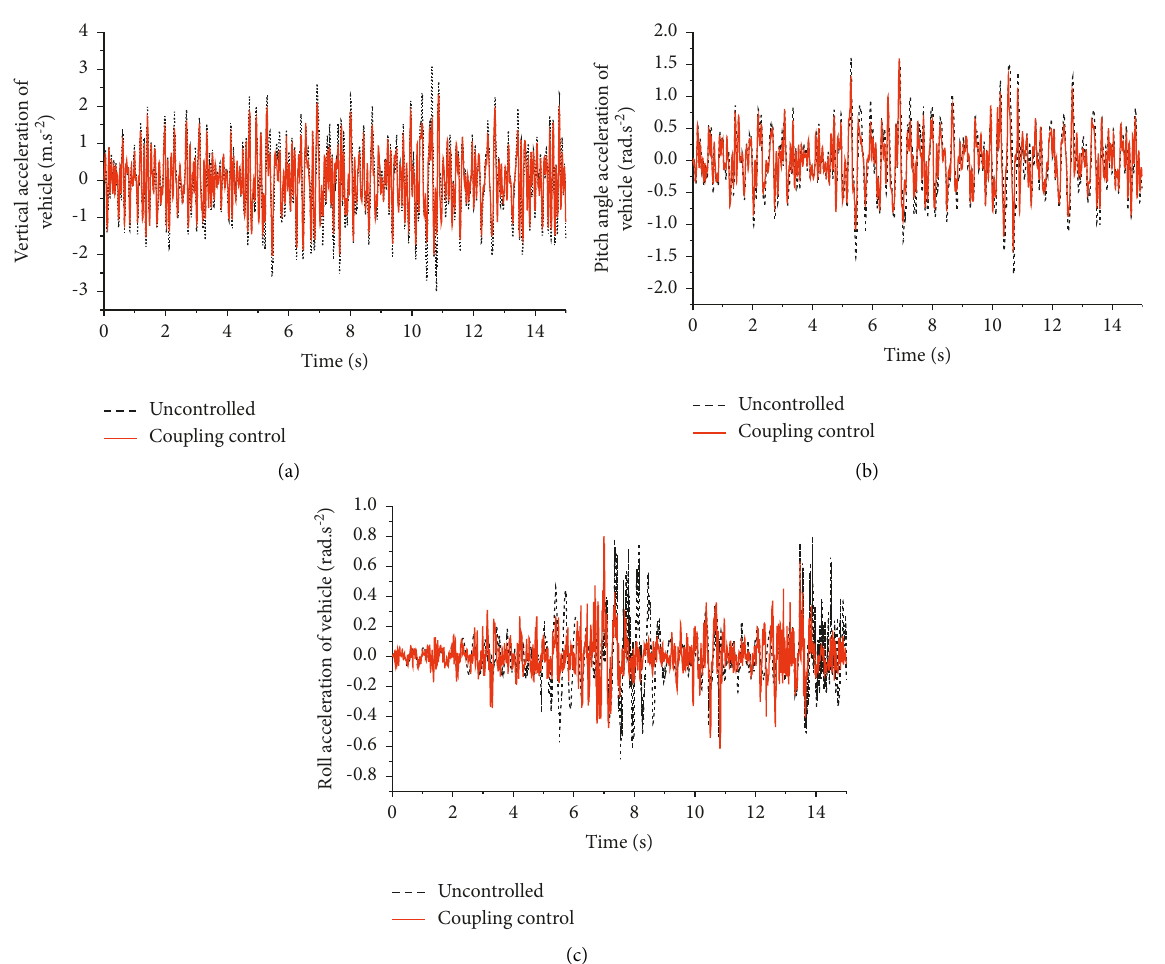
Figure 12: Ride comfort control result under serpentine condition. (a) Vertical acceleration of vehicle. (b) Pitch angle acceleration of vehicle. (c) Roll acceleration of vehicle.